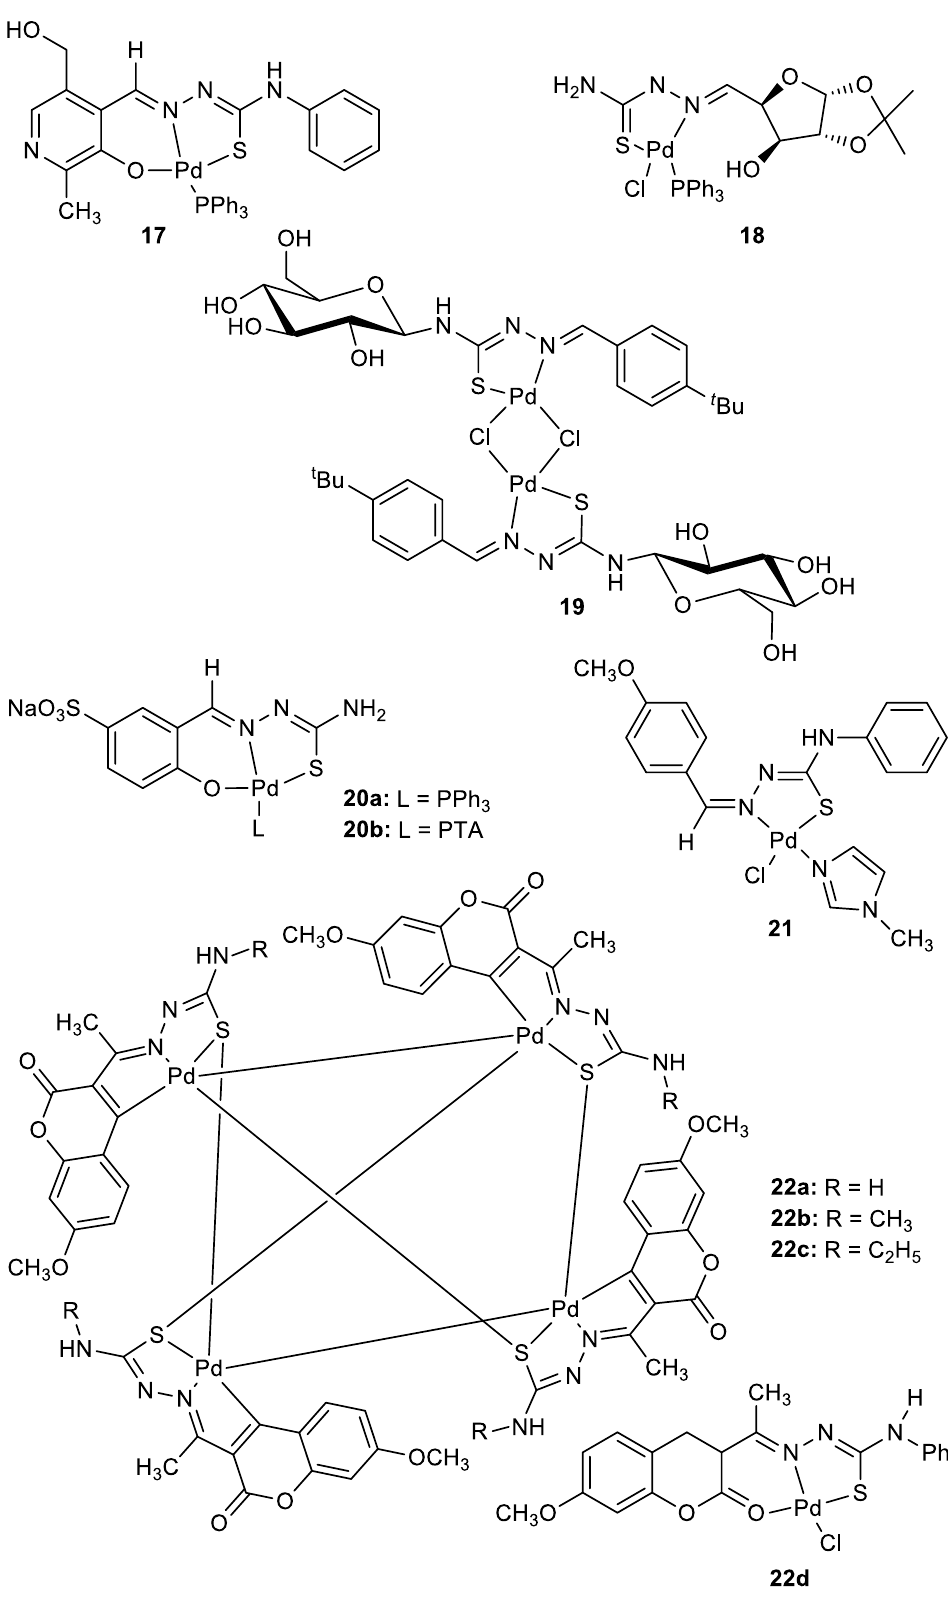
Figure 3. Representative metal complexes of thiosemicarbazones as catalysts for the Suzuki–Miyaura and other coupling reactions (Part B).